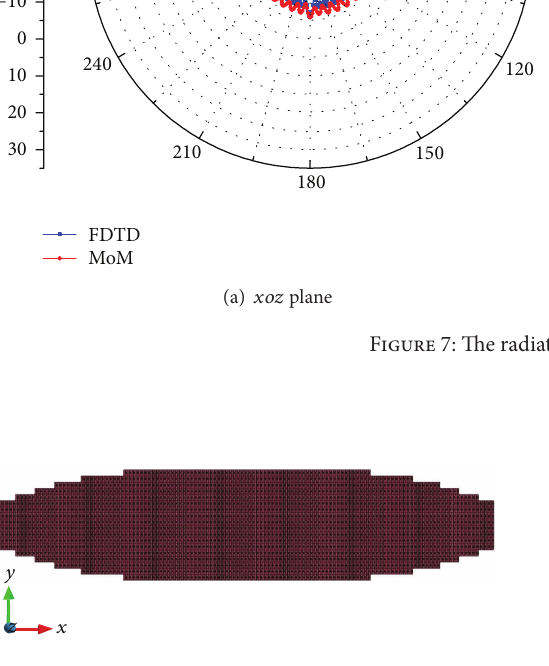
Figure 8: The model of the microstrip array.